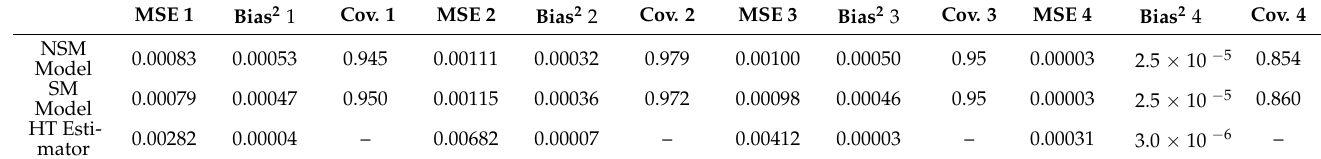
Table 3. Multinomial simulation MSE, squared bias, and 95% credible interval coverage rate by category (1–4). The results are averaged across the 49 geographic areas. Simulated data are based on Week 1 of the Household Pulse Survey.